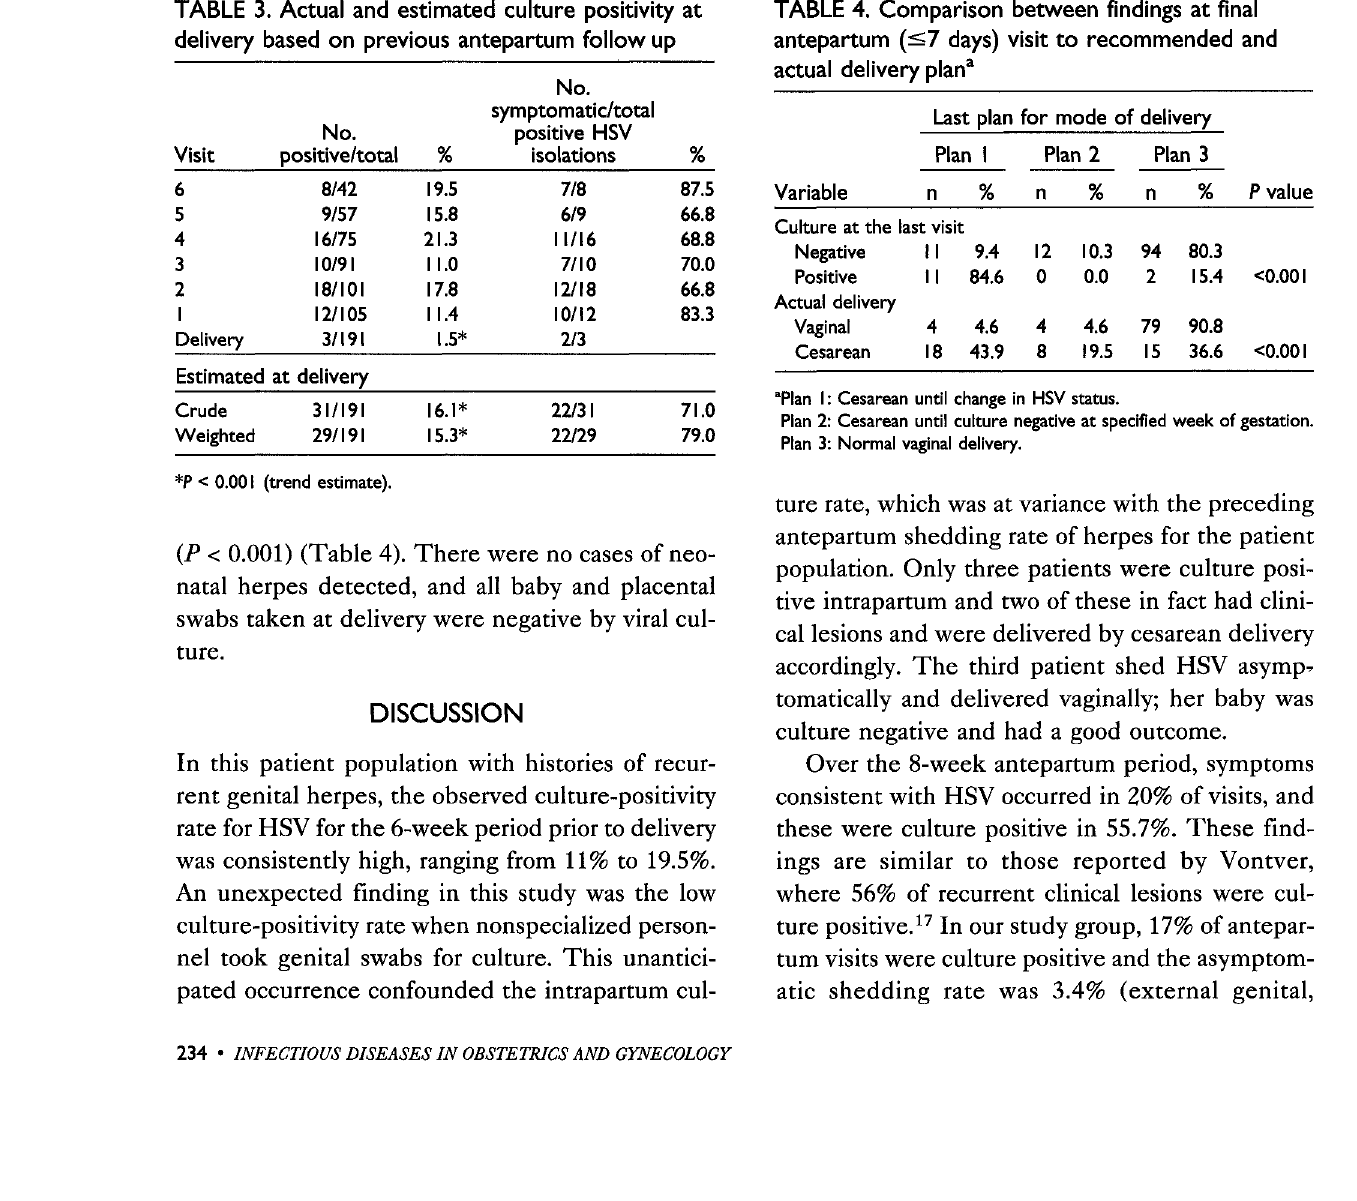
Fig. I. Predicting HSV shedding from the genital tract. Positive predictive value (PPV) (,) of culture as the predictor. Positive predictive value (O) of clinical assessment is. the predictor of herpes shedding from the genital tract in subsequent patient visit. TABLE 4. Comparison between findings at final antepartum (-<7 days) visit to recommended